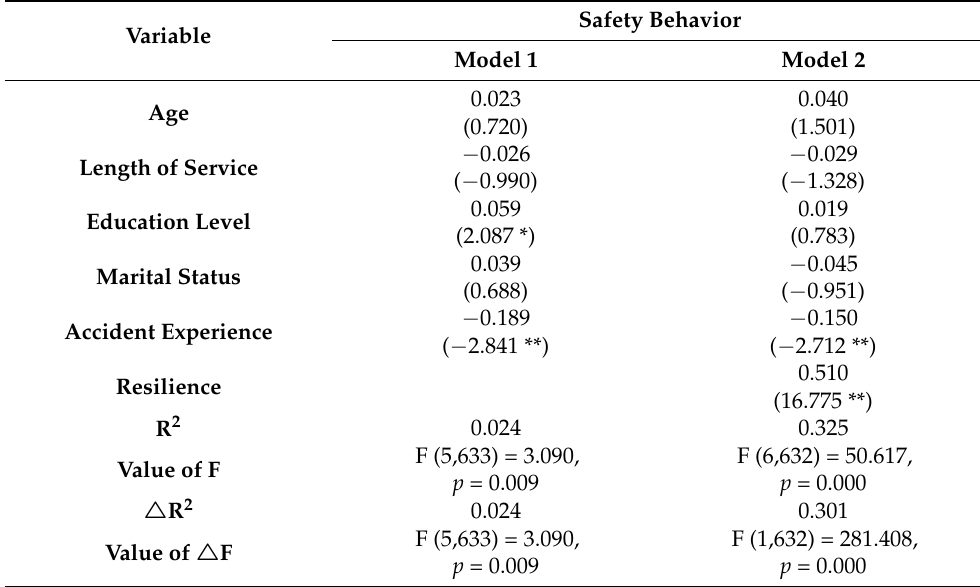
Table 9. Regression analysis of resilience on safety behavior (N =